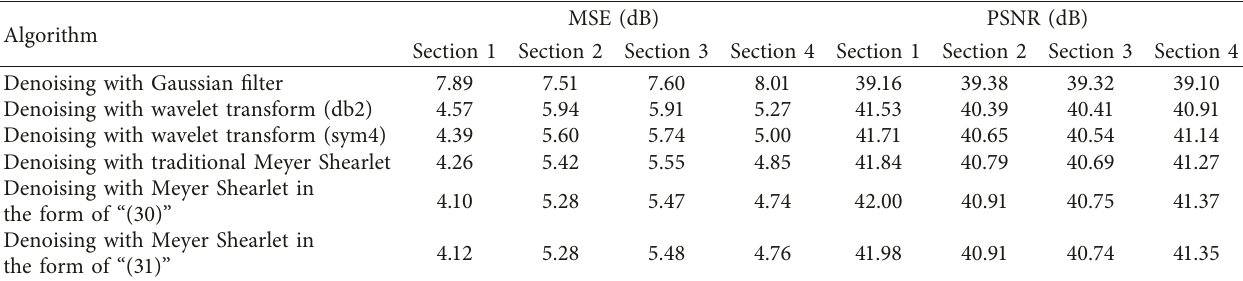
Table 1: Objective evaluation